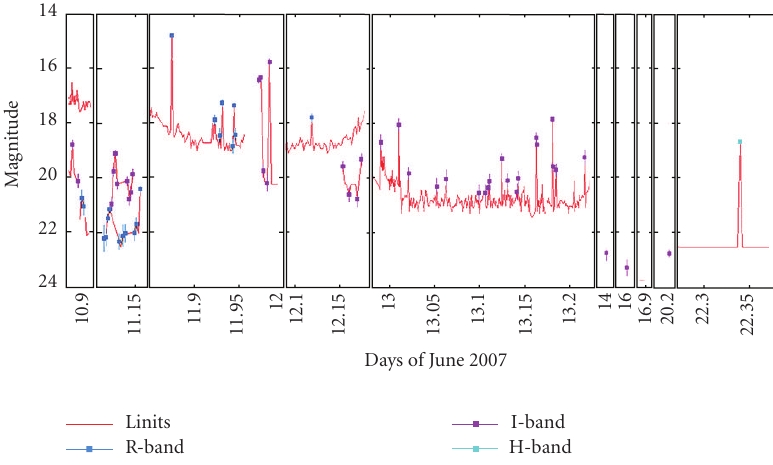
Figure 13: Optical light curve of flaring counterpart of